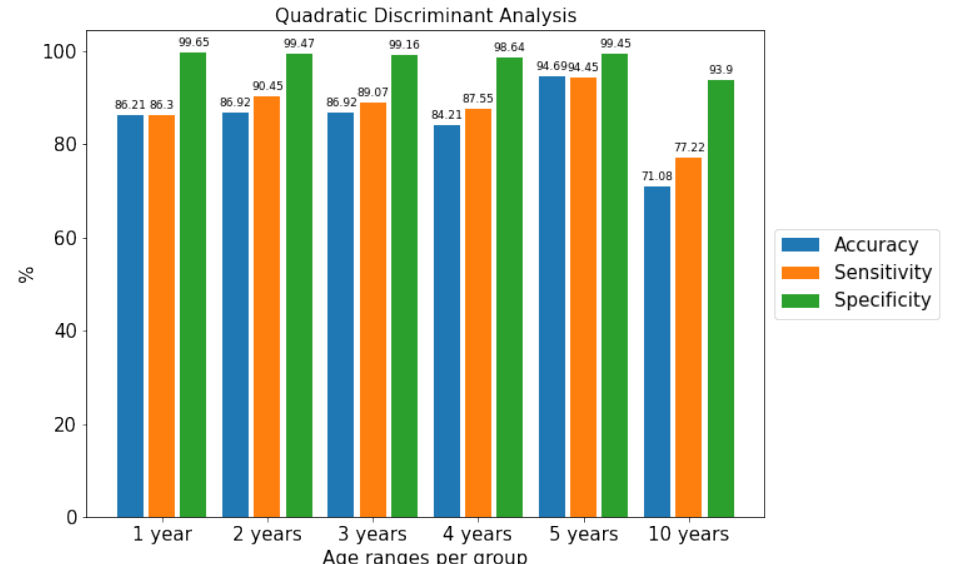
Figure 5. Comparison of the metrics of the best algorithm separated by age ranges using the Quadratic Discriminant Analysis algorithm.